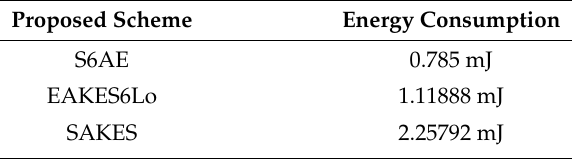
Table 8. Transmission energy